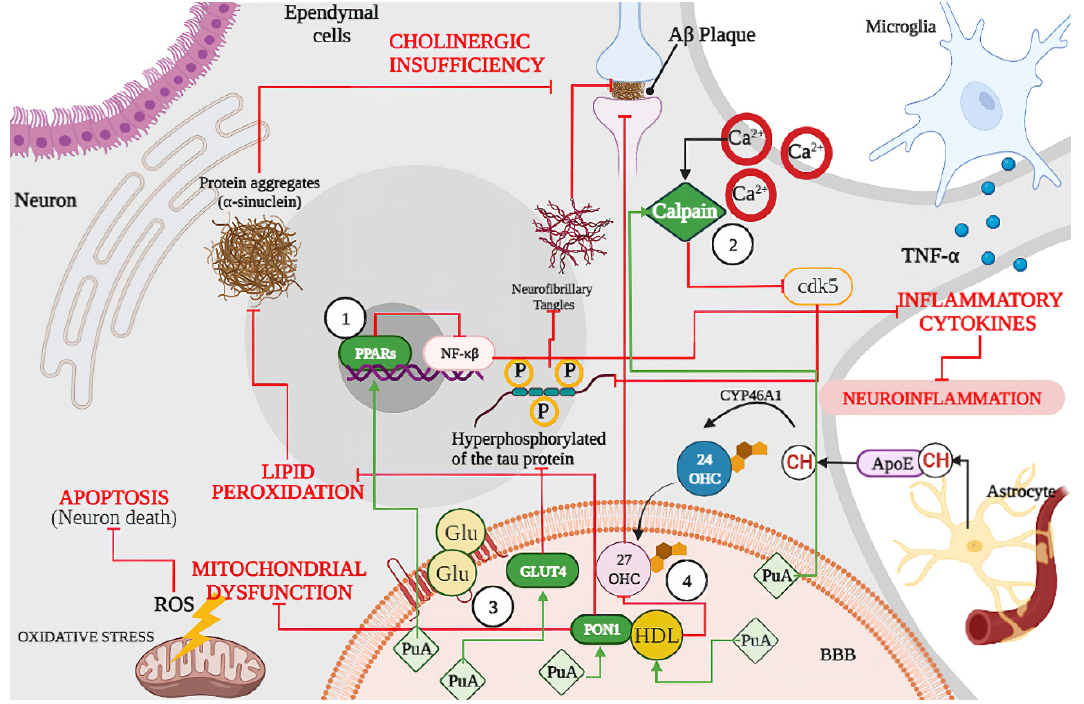
Figure 6. Schematic representation of biological effects of punicic acid (PuA) in neurological diseases (NDs). Punicic acid (PuA) acts as (1) an agonist of PPARs inhibiting the activation of nuclear factor kappa B (NF- κ B) and the release of inflammatory cytokines such as TNF-alpha, and therefore, reducing neuroinflammation and tau hyperphosphorylation and conducting less A β formation and aggregation. (2) PuA inhibits activation of calpain and cyclin-dependent kinase 5 (cdk5), limiting the hyperphosphorylation of tau protein and conducting to less A β formation and aggregation. (3) PuA increases GLUT4 protein expression regulating the glucose brain metabolism, reducing insulin resistance, and reducing the hyperphosphorylation of tau proteins. (4) PuA increased the anti-oxidative properties of the PON1 complex reducing ROS generation limiting mitochondrial dysfunction and neuronal apoptosis. Lipids peroxidation. Moreover, PuA induces changes in high-density lipoproteins (HDL) lipid composition and functionality reducing the formation of oxysterols such as 27-hydroxycholesterol (27-OHC) and increasing oxidative resistance with less A β plaque formation. ROS: reactive oxygen species; PON1: paraoxonase 1; PPARs: peroxisome proliferator-activated receptors; HDL: high-density lipoprotein; GLUT4: insulin-sensitive glucose transporter; CH: cholesterol; BBB: blood–brain barrier; ApoE: apolipoprotein E; Glu: glucose, PuA: punicic acid. Green lines indicate stimulation, while red lines indicate